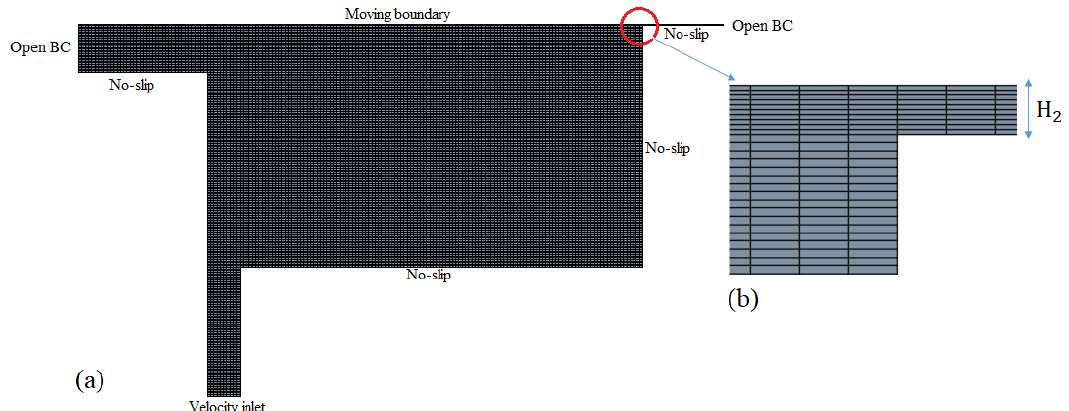
Figure 2. ( a ) Computational grid and boundary conditions used in the SDC model, ( b ) magnified view of the mesh 4 at the entry of the narrow channel.